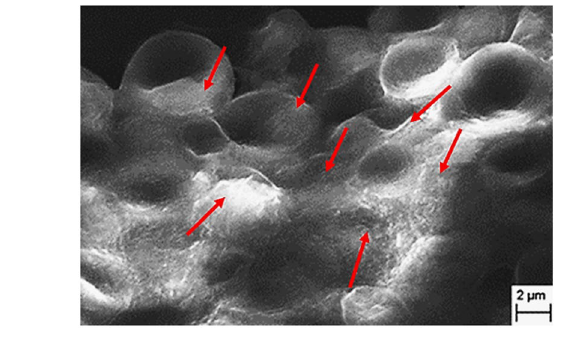
Fig. 2 Analysis Scanning electron microscopic (SEM) for treated microalga Chlorella sp.